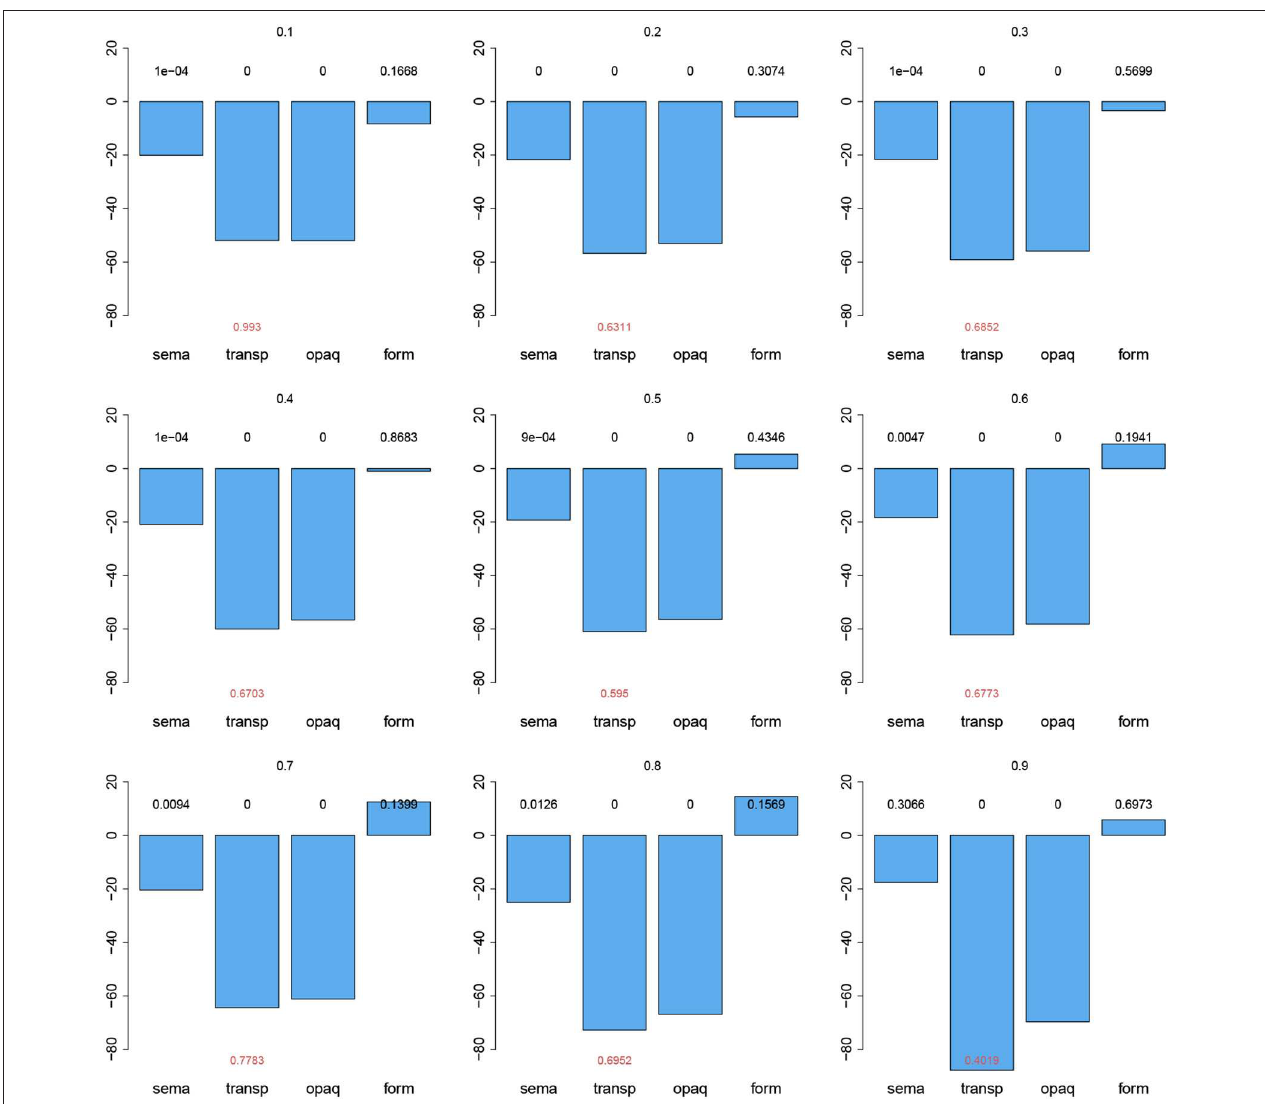
FIGURE 1 | Effects of Prime Type (with unrelated as reference level) in a Quantile GAM fitted to primed lexical decision latencies, for deciles 0.1, 0.2, …,